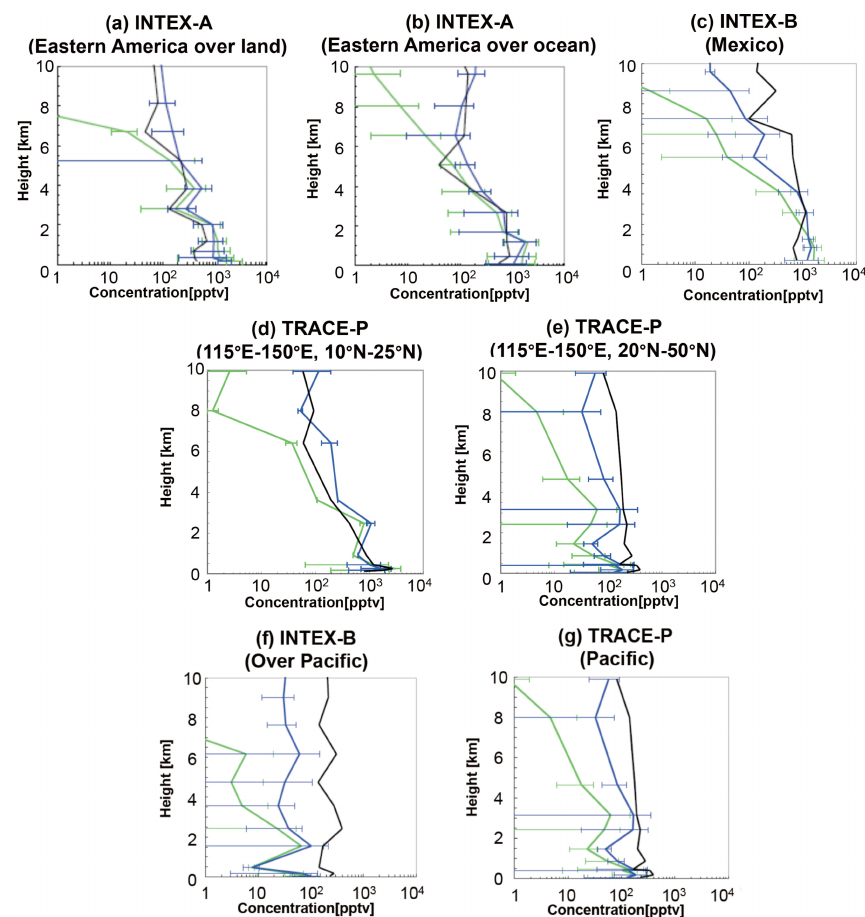
Fig. 6. Vertical profiles of the simulated and observed sulfate mixing ratios during the INTEX-A, the INTEX-B, and the TRACE-P. The black, blue, and green lines represent the observations, the simulations in NS and OS, respectively. The x-axis is mixing ratio in unit of pptv and the y-axis is height in